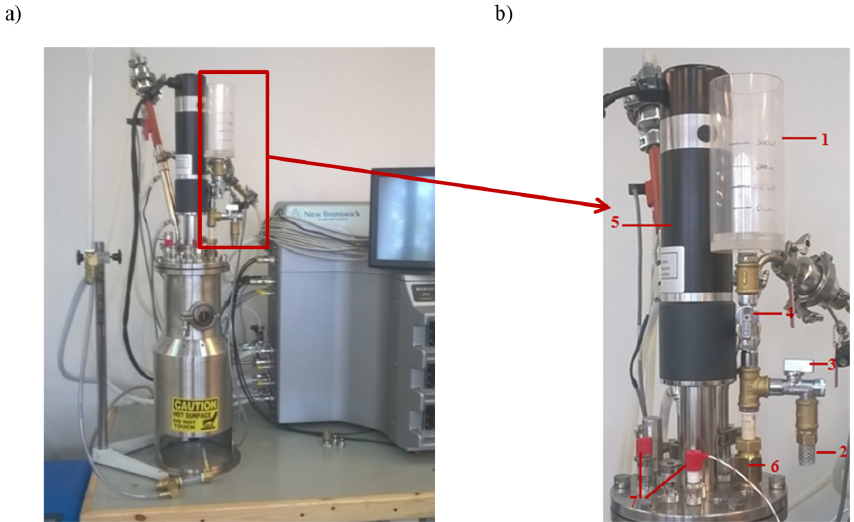
Figure 2. The view of the bioreactor BioFlo ® 415 ( a ) with the batching system of the tracer ( b ). The batching system of the tracer consisted of 1—the batcher; 2—the water supply hose to the mixing system; 3—the cut-o ff valve for the water supply hose to the mixing system; 4—the dosage valve for